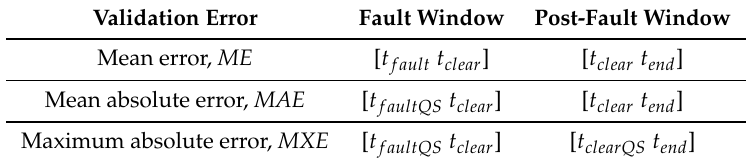
Table 1. Time periods considered for the calculation of the validation errors based on Figure